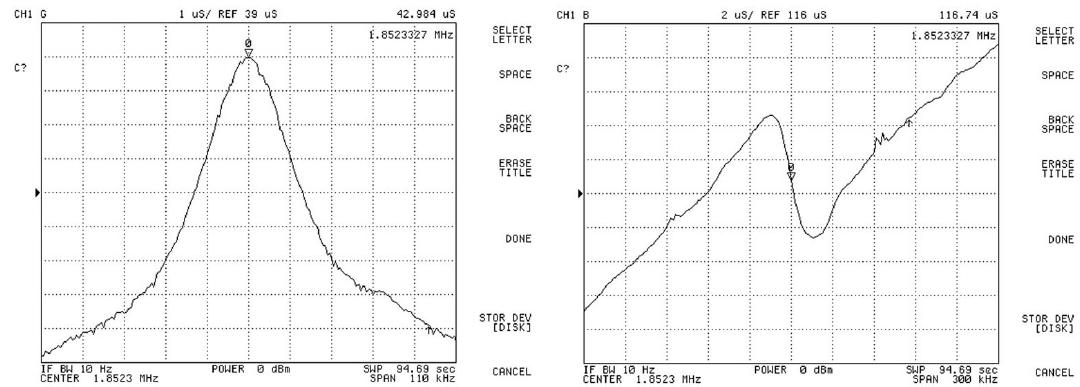
Figure 12. The admittance curves of pMUT with partially-etched ZnO film.